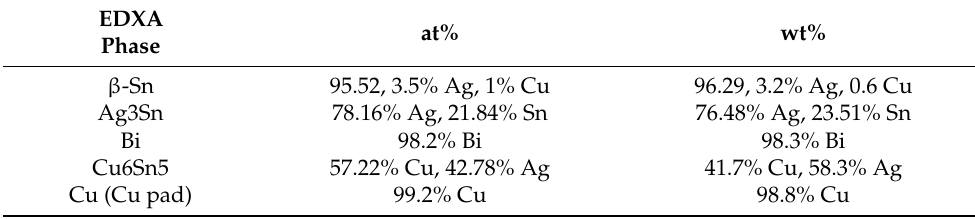
Figure 6. Microstructure of the junction area between Cyclomax and the copper pad of a sample that has not undergone thermal aging. Table 1. EDXA analysis of